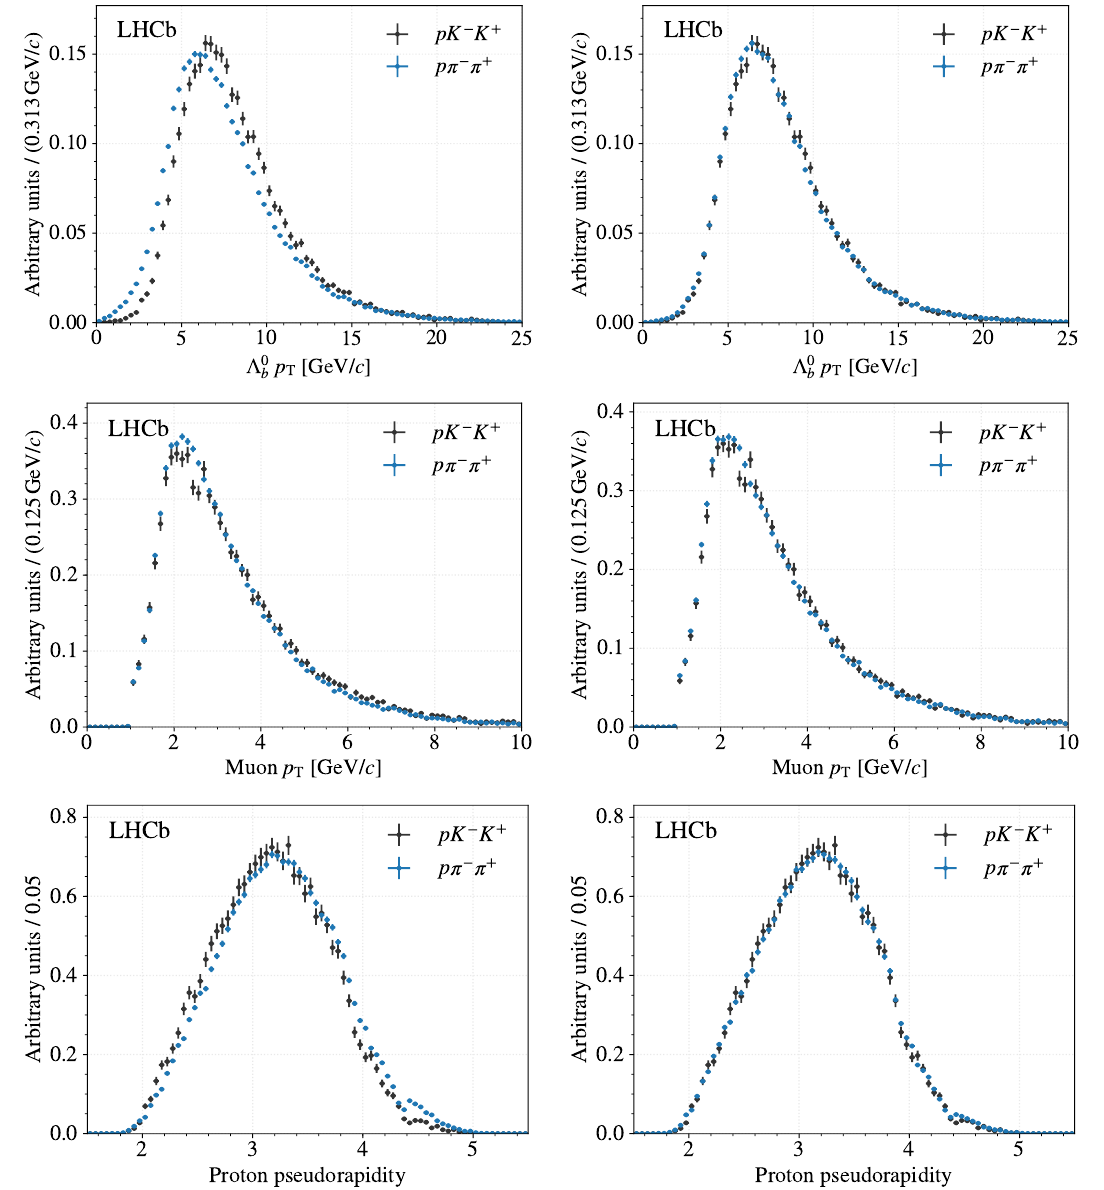
Figure 2 . Background-subtracted distributions of the (cid:3) 0 candidate transverse momentum (top b row), the muon candidate transverse momentum (middle row), and the proton candidate pseudo- rapidity (bottom row) both before (left column) and after (right column) weighting the p(cid:25) (cid:0) (cid:25) + sample (blue points) to match the pK (cid:0) K + sample (black points). The data are summed across all data-taking conditions.